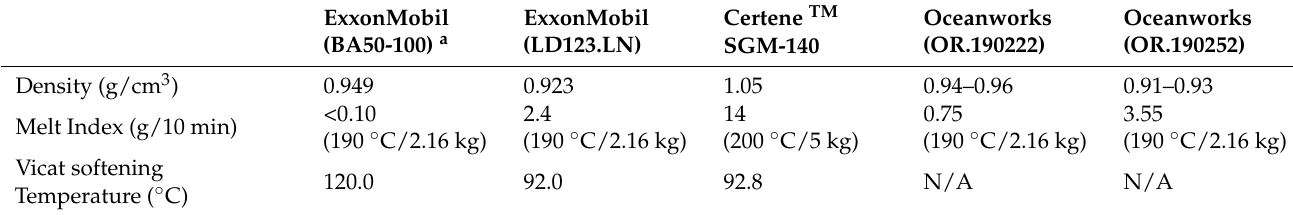
Table 4. Properties of polymers used in this